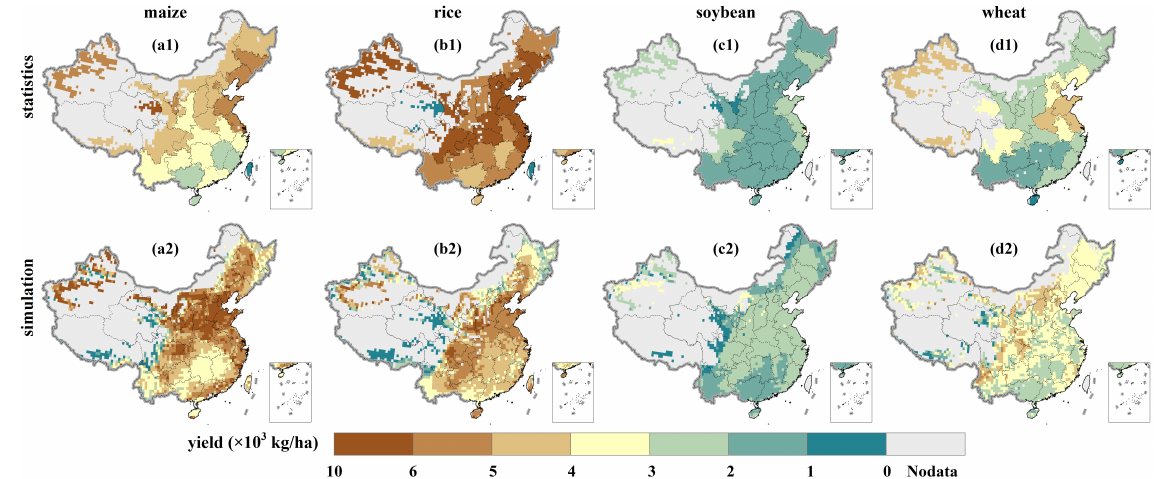
Figure 2. The MMs of the simulated yields with the CO 2 effect and NBSC reported yields of the four major crops in China during 1981– 2010. The upper panels are the NBSC yields and lower panels are the simulated yields. The median of the simulated crop yield among the GCM–GGCropM pairs is provided at 0.5 ◦ grids. The NBSC yields at each province are plotted at the crop area shown in Fig.